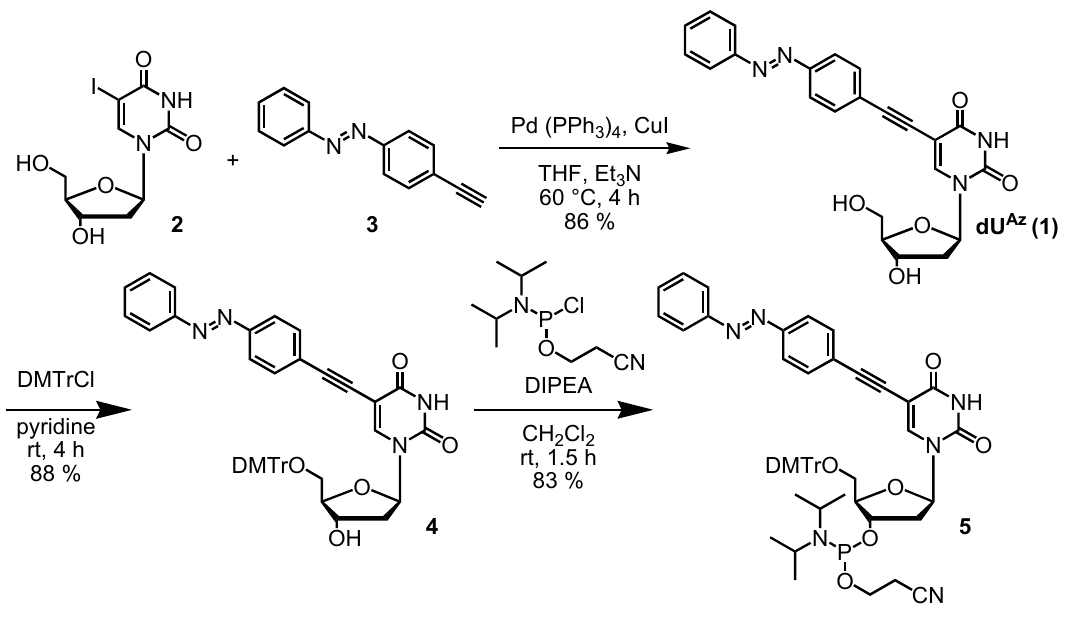
Scheme 1. Route for the synthesis of dU Az phosphoramidite.